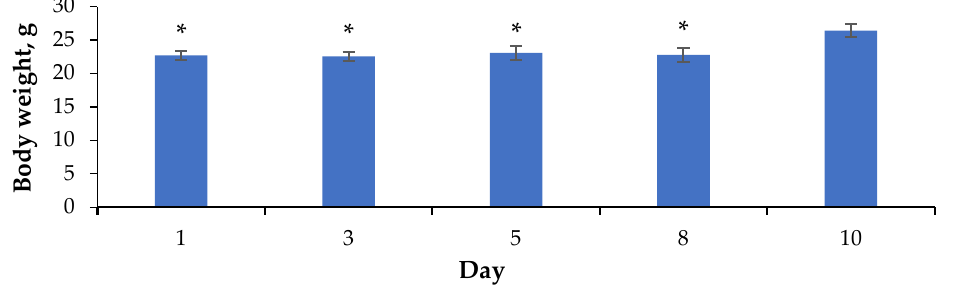
Figure 9. Body weight of CD-1 mice after a single injection of QS-528 at a dose of 1000 mg/kg. * p ≤ 0.05 as compared to the mouse weight after 10 days of QS-528 introduction.